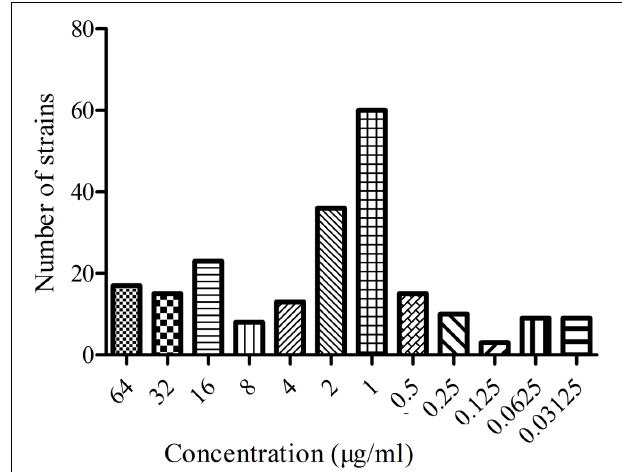
FIGURE 1 | The MIC distribution of MBF against 218 E. coli